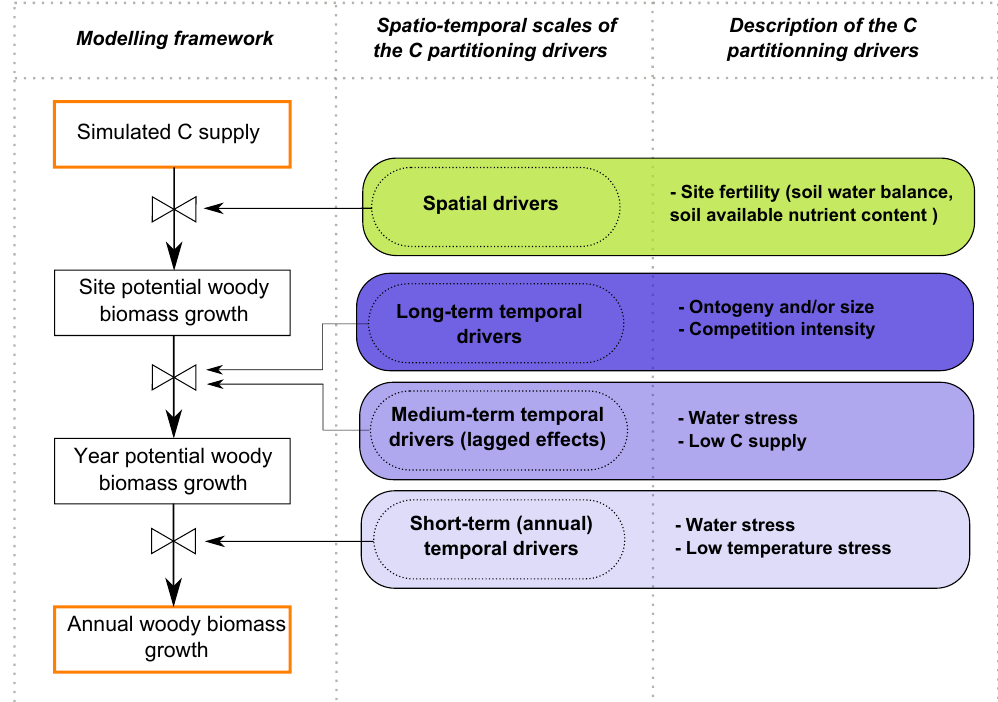
Figure 6. Modelling framework for a combined source- and sink-driven representation of C allocation to wood